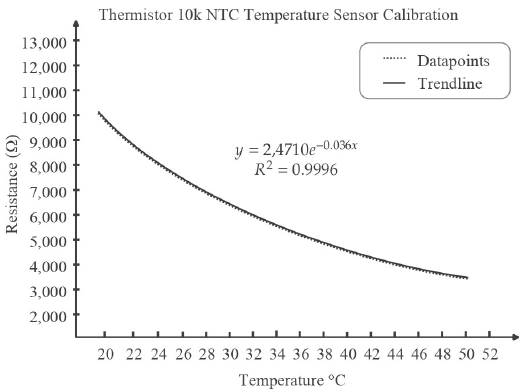
Figure 9. Thermistor resistance vs. temperature plot and exponential fitting curve.